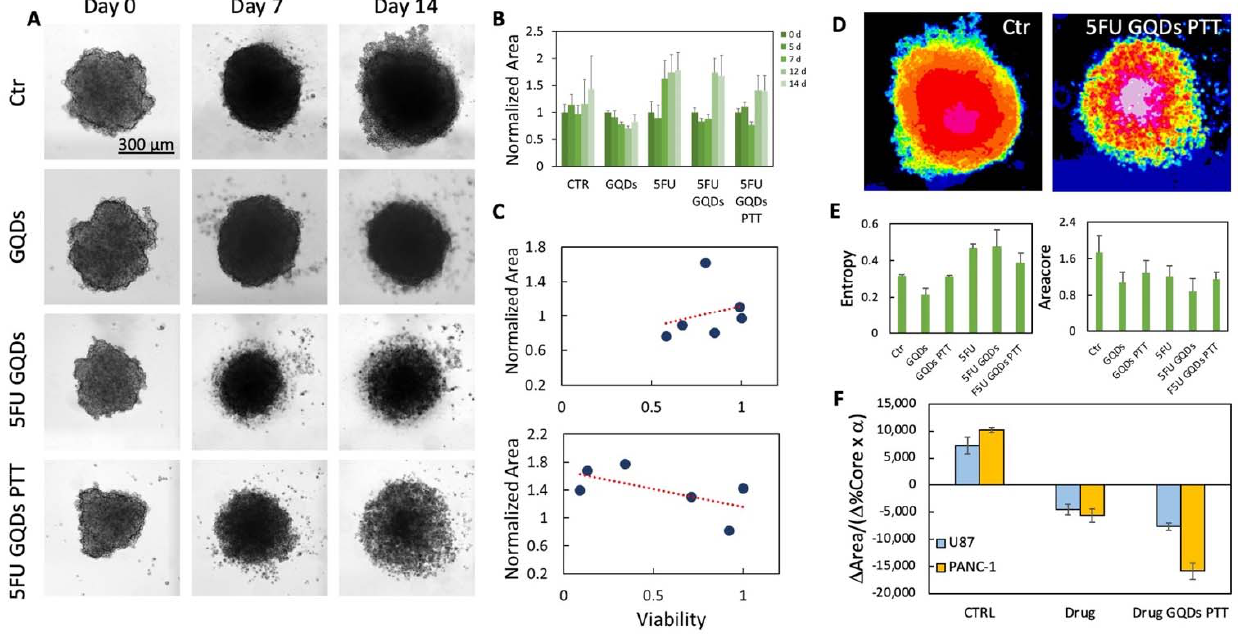
Figure 5. ( A ) Representative images at day 0, 7, and 14 of PANC ‐ 1 spheroids treated with GQDs, 5FU GQDs or 5FU GQDs PTT. ( B ) Effect of treatments on spheroids area obtained from binarized images and normalized to Day 0. ( C ) Correlation between normalized area and viability after 7 or 14 days of treatment. ( D ) Representative images of Ctr or 5FU GQD PTT ‐ treated spheroids with 16 colors in the table to highlight differences in grayscale texture. ( E ) The area of the core obtained from spheroids profiles and entropy of spheroids after 24 days of different treatments. ( F ) Parameter quantifying spheroid disruption after 14 days of treatment.